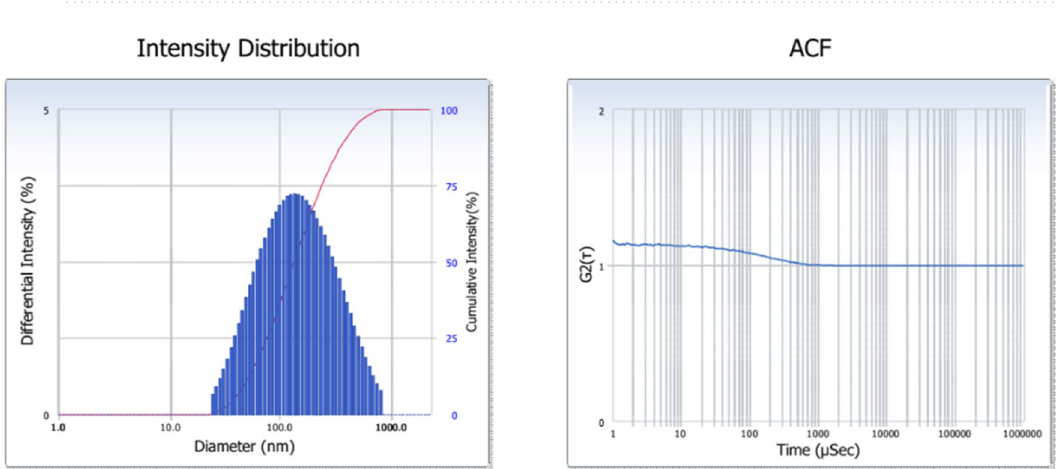
Figure 5. Analysis of Silver nanoparticles using DLS of Sargassum